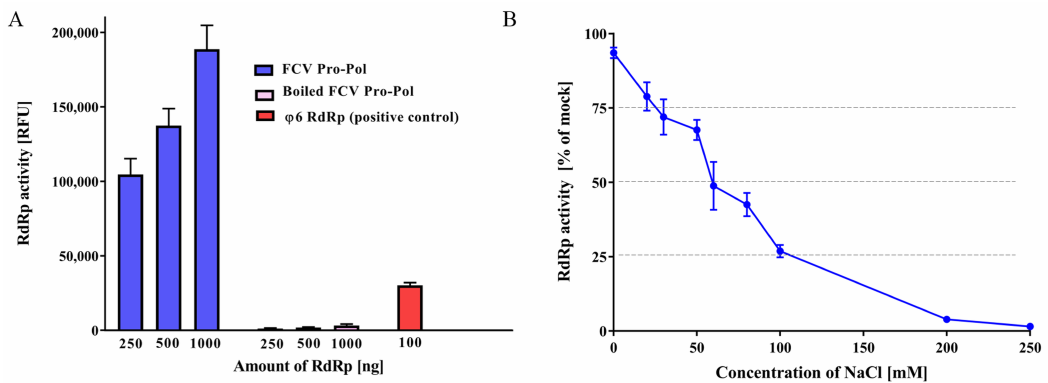
Figure 1. The characterization of FCV RdRp activity. ( A ) Purified recombinant FCV RdRp was used to generate dsRNA from a poly(C) RNA template using rGTP as a substrate (2.5 mM and 0.2 mM final concentration, respectively). Following 1 h of incubation at 30 ◦ C, the reactions were stopped with 10 mM EDTA and dsRNA was quantified using the fluorescent dye PicoGreen. Heat-inactivated FCV RdRp was used as a negative control, and the Pseudomonas syringae bacteriophage ( ϕ 6) RdRp was used as positive control. ( B ) The effect of NaCl concentration on polymerase activity. Triplicate values from three independent experiments are plotted as the mean ± SEM. The baseline NaCl concentration of the reaction mixture before any additional NaCl was 3 mM. Relative fluorescence units